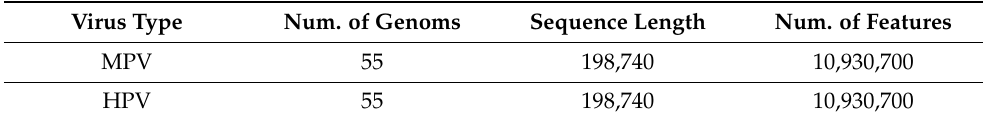
Table 1. Information about the data set in the study. Virus Type Num. of